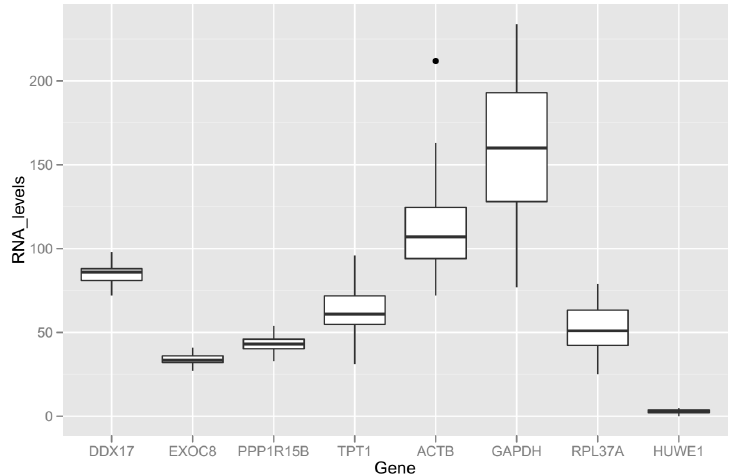
Figure 3. Box plot of the RNA levels of eight candidate reference genes in all maternal blood samples subjected to an RNA-seq analysis. RNA levels are calculated by normalized read counts, which have taken into account the varying RNA input, sequencing depths, and other technical variations. The bold line inside each box is drawn to the median , the bottom and top of each box to the 25th and the 75th percentiles , and the whiskers to the 10th and 90th percentiles . An outlier is shown as a black dot.